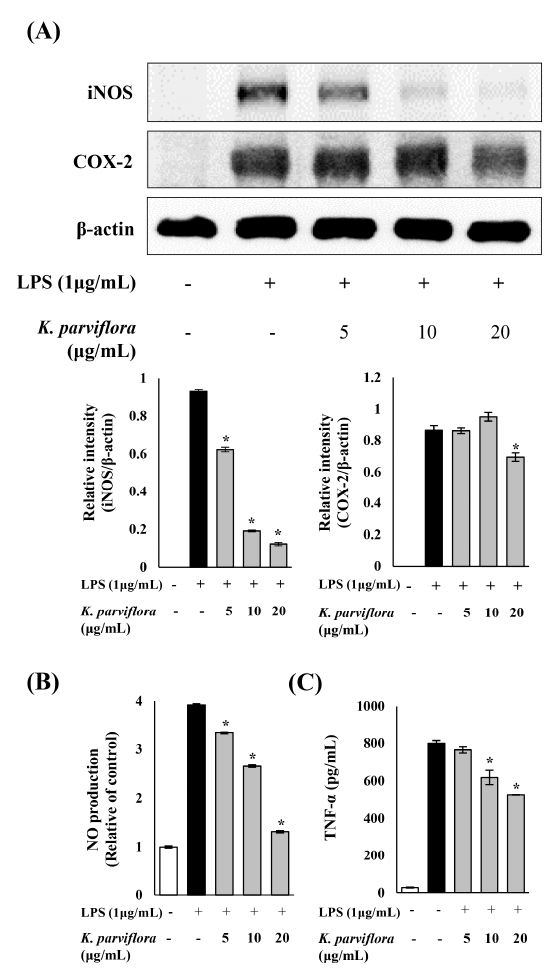
Figure 2. ( A ) Inhibitory effect of the Kaempferia parviflora extract on the expression of lipopolysaccharide (LPS)-induced inflammatory proteins, inducible NO synthase (iNOS) and cyclooxygenase-2 (COX-2), in murine macrophage-like cell line (RAW 264.7) cells. The expressions of iNOS and COX-2 were analyzed with ImageJ and normalized against β -actin; ( B ) effect of K. parviflora extract on NO production in LPS-induced inflammation in RAW 264.7 cells; ( C ) inhibitory effect of K. parviflora extract on LPS-induced TNF- α level in RAW 264.7 cells. All data are expressed as mean ± SD. * p < 0.05 compared with LPS treated cells only.